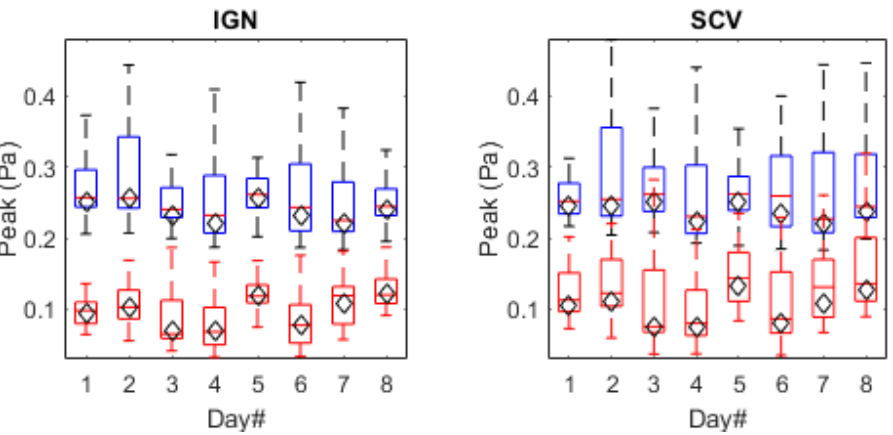
Figure 12. Peak values computed for spark and noise data at sensor locations IGN and SCV.